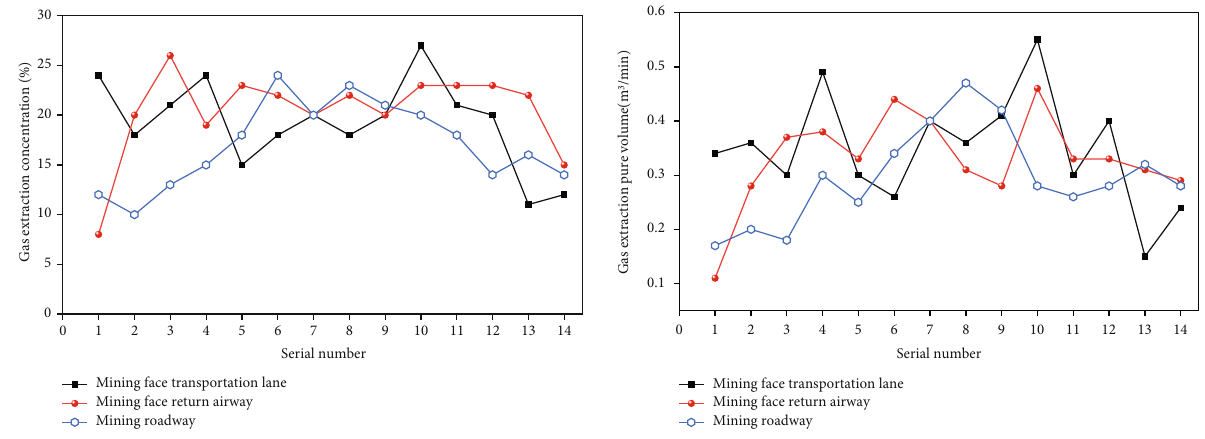
Figure 25: The concentration and scalar quantity of gas drainage in this coal